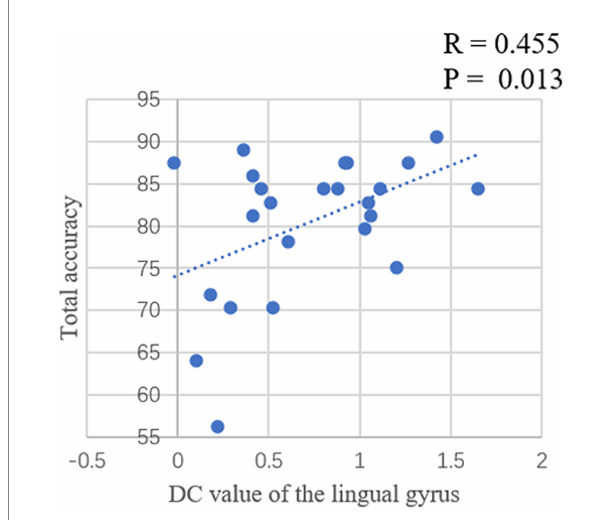
FIGURE 4 The significant relationship between the brain functional properties and behavioral indices in controls ( p < 0.05).